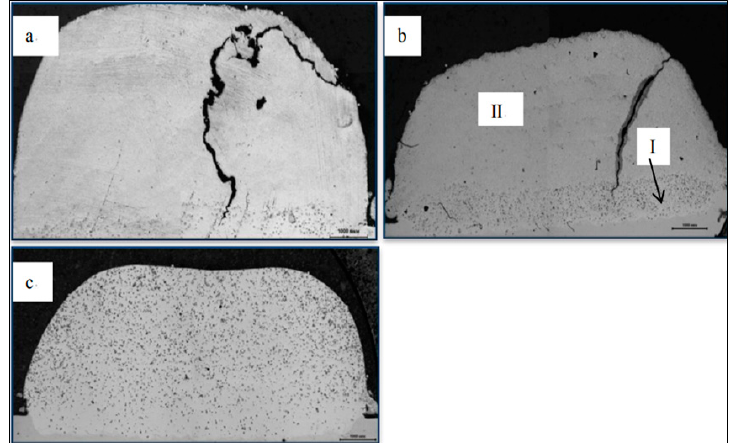
Figure 22. Microstructures of the composite materials Inconel 625/TiC obtained with a different feed of powders: ( a ) separate feed of powders; ( b ) mixing in a gravitational mixer (I—spherical crystal zone; II—dendritic crystal zone); ( c ) mixing in a planetary ball mill (adapted with permission from Ref. [69] 2018, IOP Publishing).